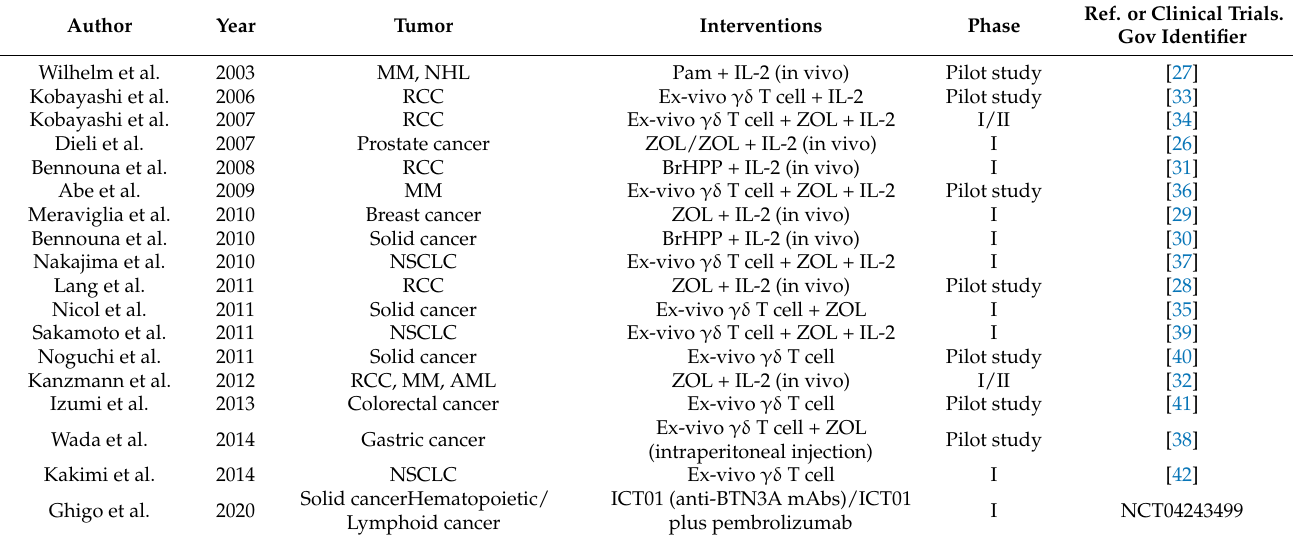
Table 1. γδ T cell-based clinical